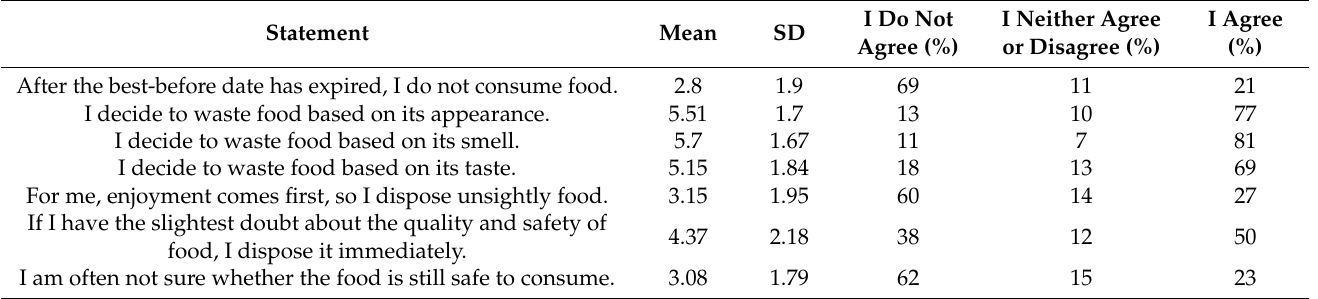
Table 6. Assessments of causes of food disposal of food using a Likert scale from 1 to 5 (1–2: I do